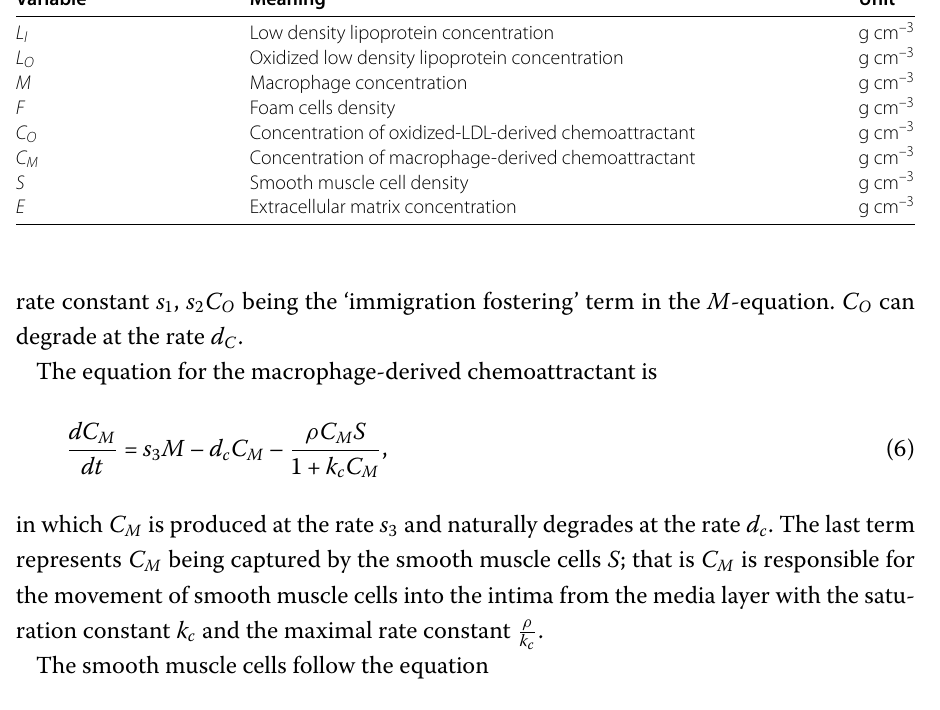
Table 1 Meanings and units of variables in the model system (1)-(8) Variable Meaning Unit L l Low density lipoprotein concentration L O Macrophage concentration F Foam cells density Concentration of oxidized-LDL-derived chemoattractant Concentration of macrophage-derived